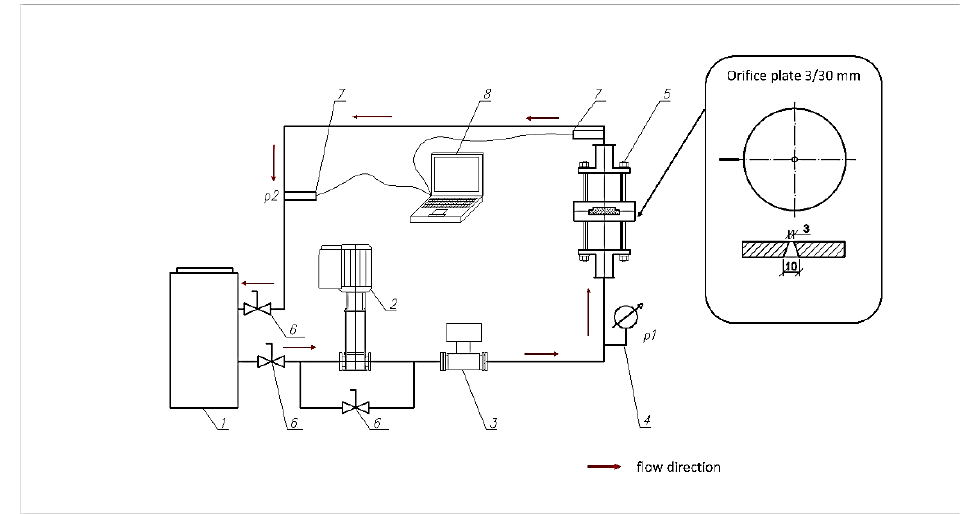
Figure 2. Scheme of laboratory installation 1 — circulation tank, 2 — pump, 3 — electromagnetic flow meter, 4 — manometer, 5 — cavitation reactor, 6 — valve, 7 — piezoelectric pressure gauges, 8 — computer unit.